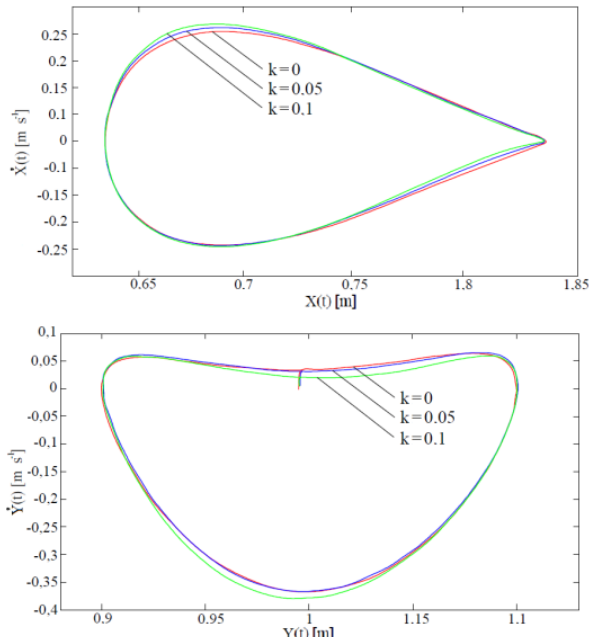
Figure 26. Phase trajectories of the motion of a joint, connecting working platform with link in different values of rotational friction and with load mass of M =